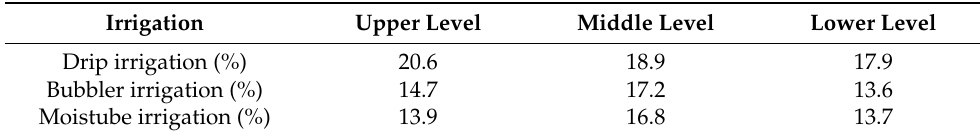
Figure 15. Shorter scan line radargrams of the moistube irrigation SWB. Note: The first line is the raw GPR radargram of a SWB with different irrigation volumes and depths, named “irrigation volume–depth.” The second line is the FK migration results of the first line, named “FK-irrigation volume–depth.” The third line is the FK radargram of a SWB, with a rough outline of said SWB (green dotted line). Table 4. The moisture content of the three kinds of